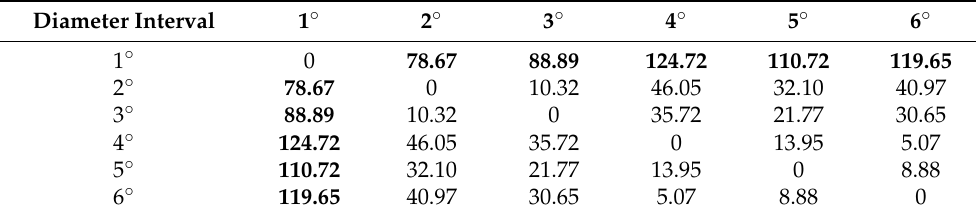
Table 4. HSD test for the mean values of each diameter interval after application of the Tukey test. Diameter Interval